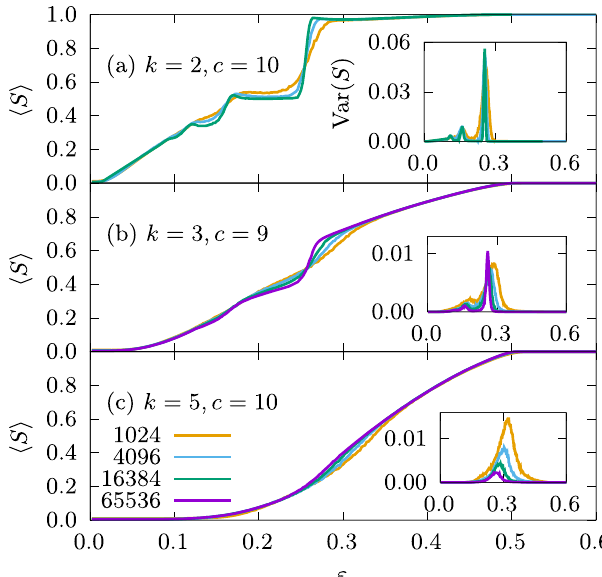
Fig. 4 Behaviour of the mean relative size of the largest cluster for the Barabasi – Albert hypergraph. Mean relative size of the largest cluster h S i as a function of the con fi dence ε for the HOID model on k -uniform BA hypergraph with k = 2 ( a ), k = 3 ( b ), k = 5 ( c ), and expected mean degree of c = 10 for different system sizes. The insets show the variance Var( S ), which is sharpening for k ≤ 3 and vanishing for k = 5; the same behaviour as for the